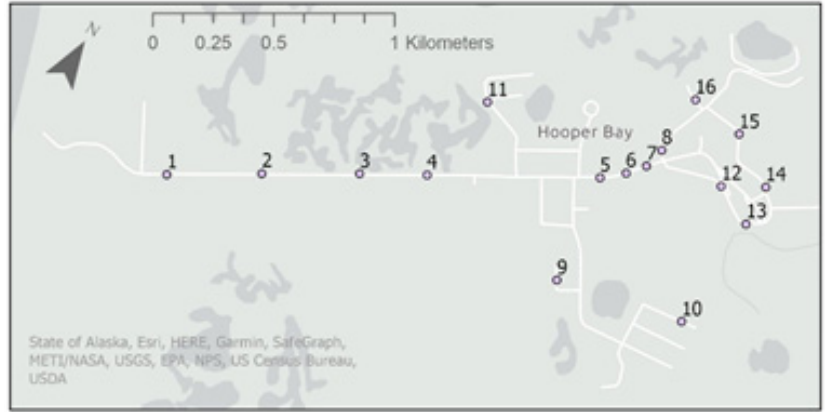
Figure 4. Model observation points.